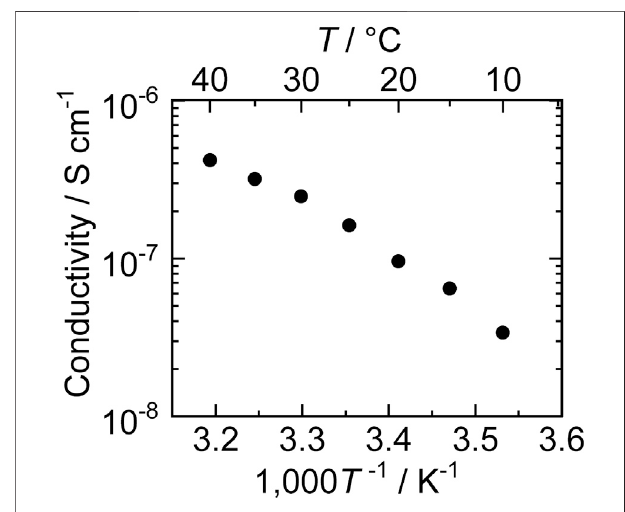
FIGURE 6 | Temperature dependence of the ionic conductivity of